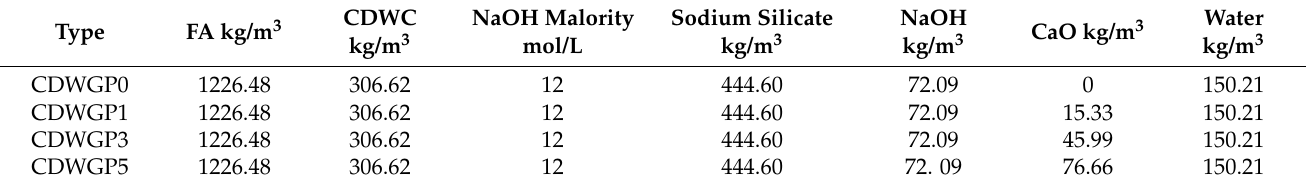
Table 5. Mix proportion of